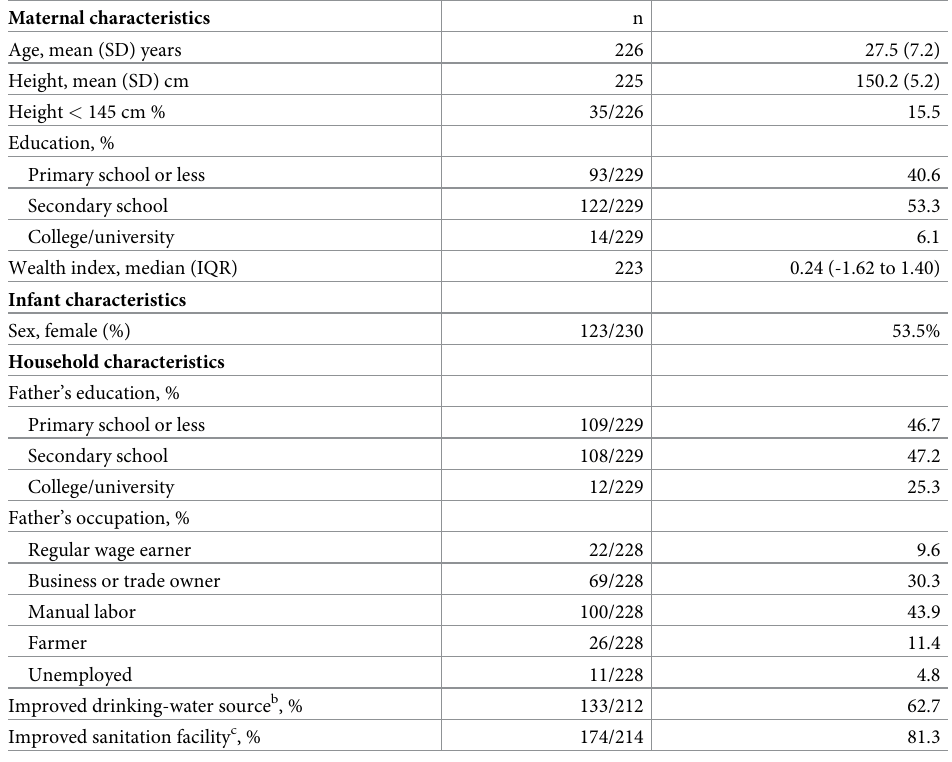
Table 1. Maternal, socio-economic, infant, and household